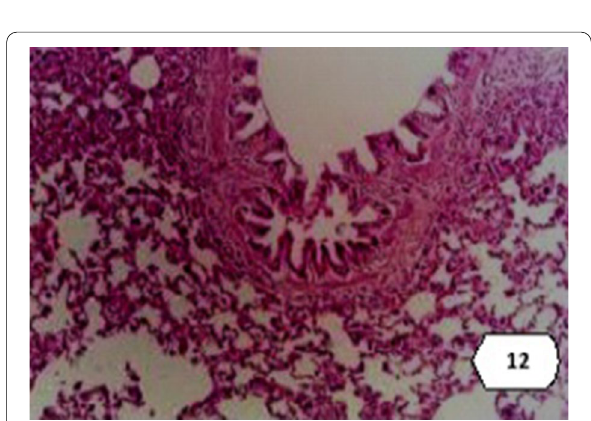
Fig. 12 Lung tissue image of Ch-NPs animals showing diffused focal proliferation of inflammatory cells associated with fibrous tissue (hematoxylin and eosin 200 magnification) ×